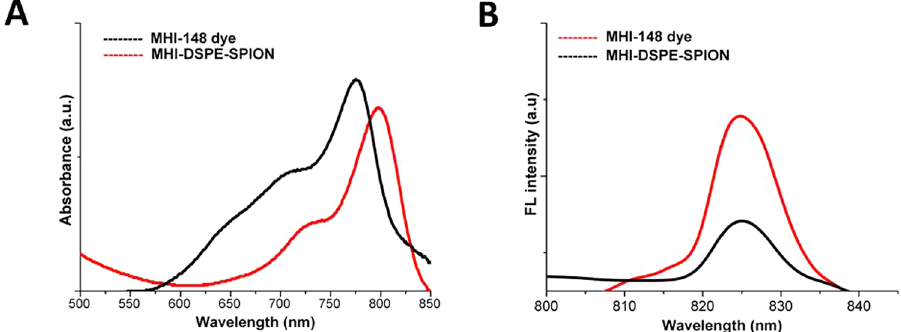
Figure 3. Ultraviolet–visible absorbance and fluorescence of free ( A ) MHI-148 dye and ( B ) MHI-DSPE-SPION